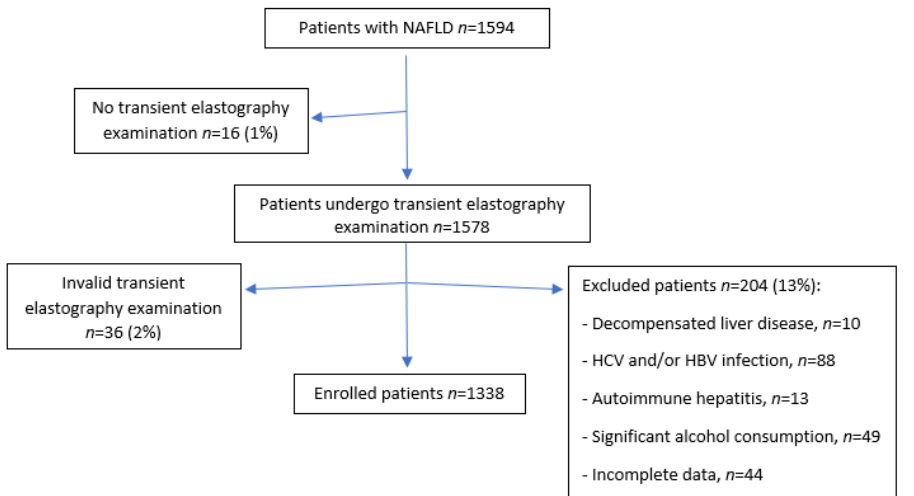
Figure 2. Flow chart with numbers of excluded Figure 2 . Flow chart with numbers of excluded patients.